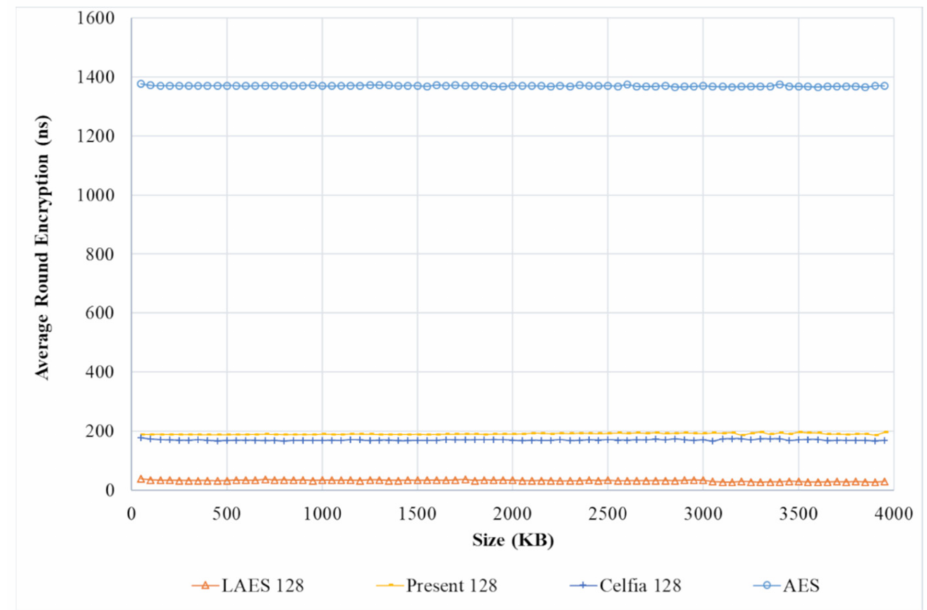
Figure 9. Average encryption time for a single